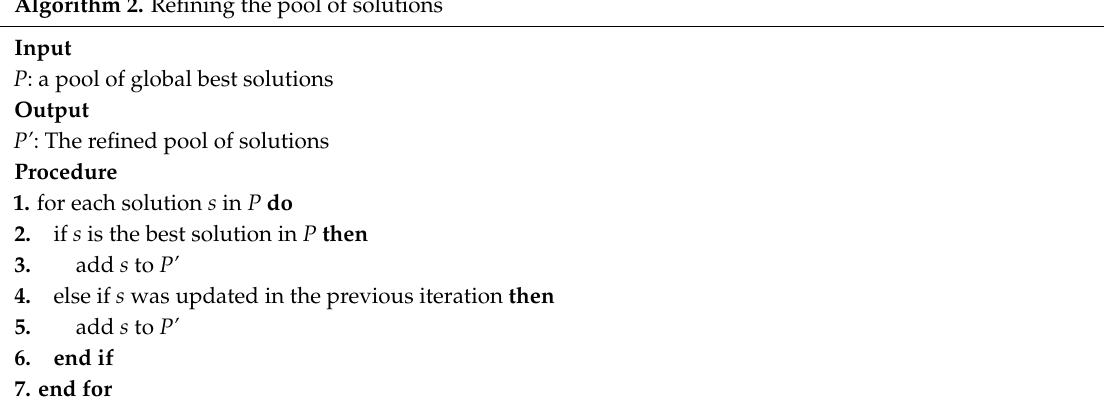
Algorithm 2. Refining the pool of